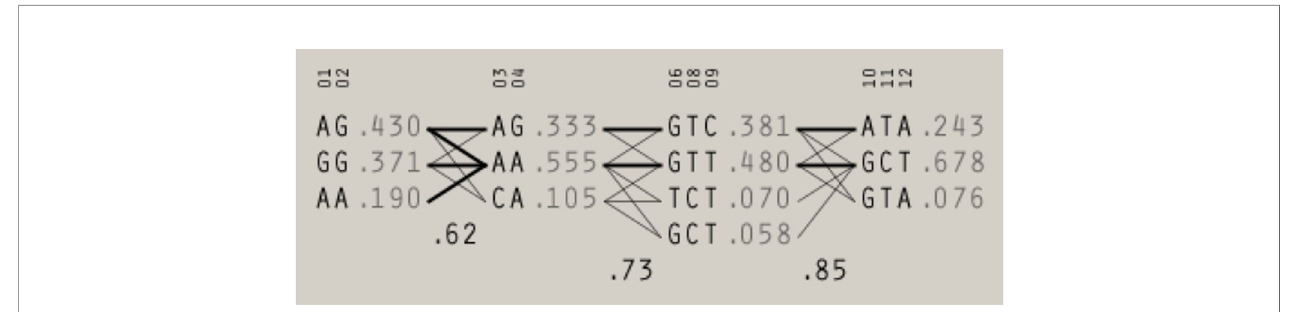
FIGURE 2 | The haplotype blocks identi fi ed in preterm neonates using Four Gamete Rule test. The frequency and the level of recombination between blocks are given. 01 - rs3124952 (-986); 02 - rs3124953 (-602); 03 - rs7865453 (-64); 04 - rs17514136 (-4), 06 - rs7851696 (+6424), 08 -rs73664188; 09 - rs11103564; 10